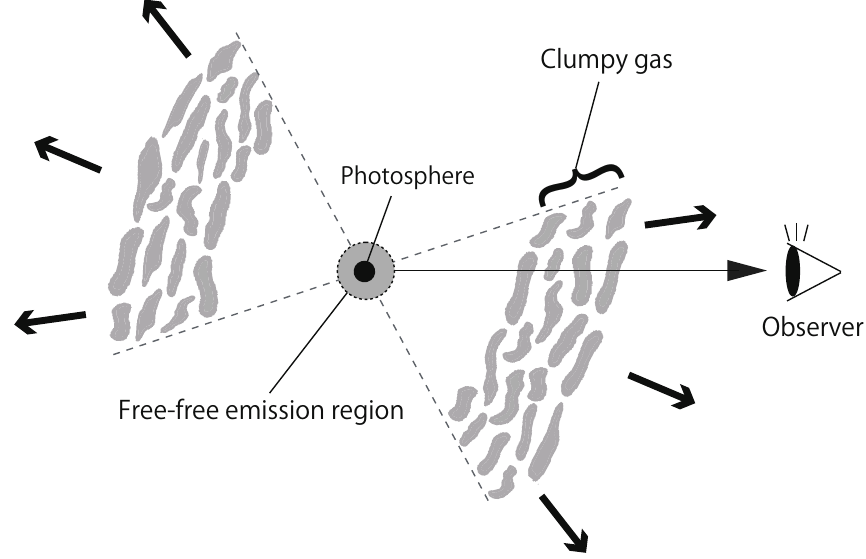
Figure 4: Schematic of ejected shell producing absorption lines of metastable He i* (see Naito et al. 2013 for